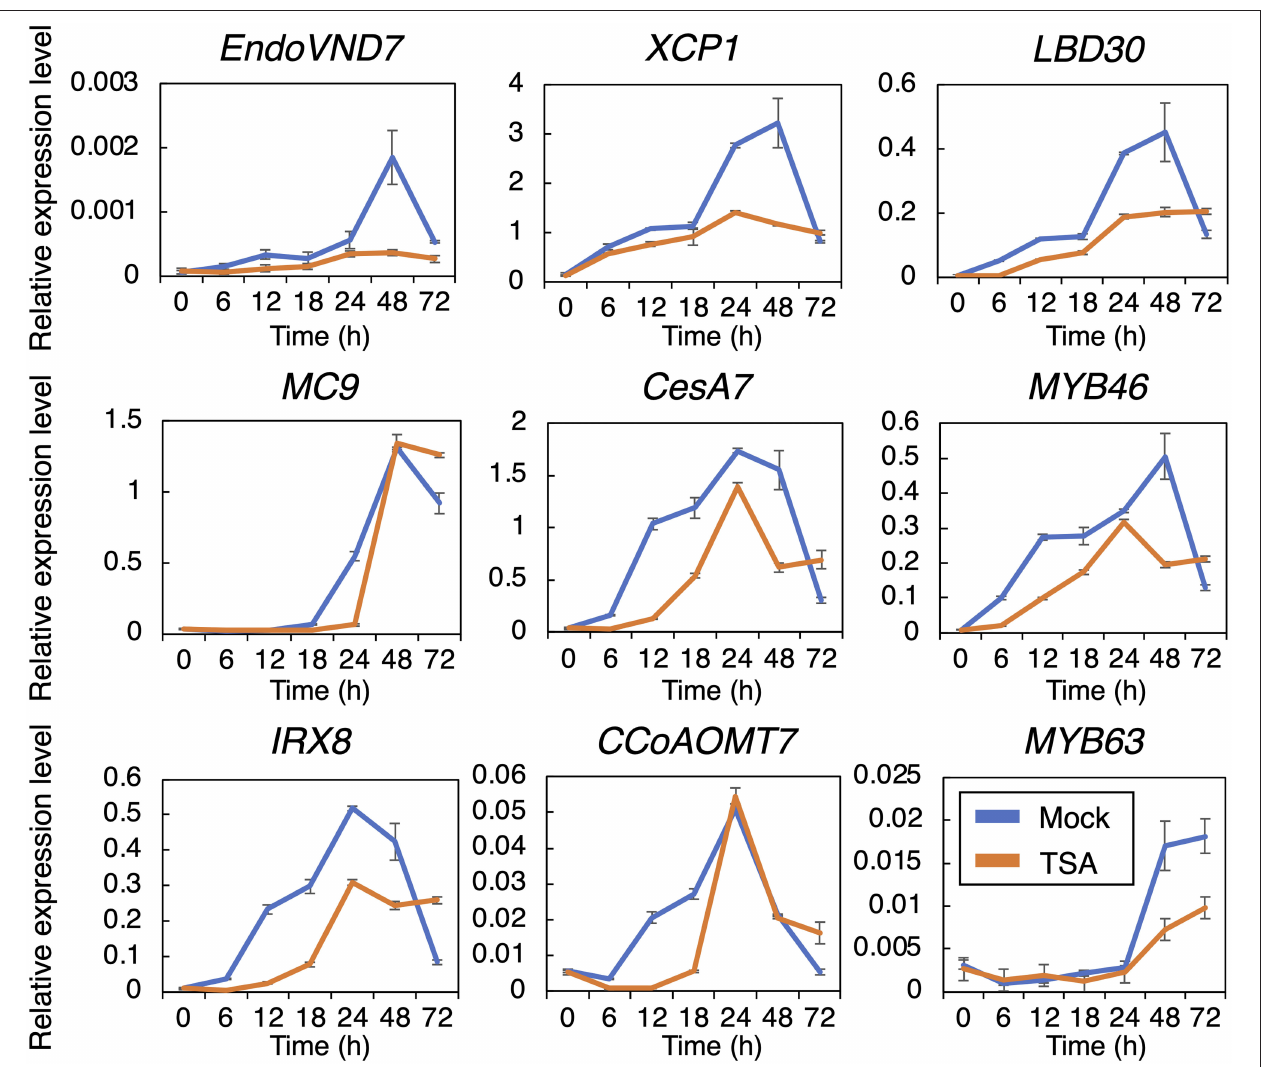
FIGURE 3 | Reverse transcription quantitative PCR analysis of the genes downstream of VND7 in VND7–VP16–GR seedlings treated with dexamethasone (DEX) and trichostatin A (TSA). Seven-day-old VND7–VP16–GR seedlings were treated with 10nM DEX and 5 µ M TSA and sampled after 0, 6, 12, 18, 24, 48, and 72h. The expression levels of the genes downstream of VND7 were normalized to the expression level of the internal control UBIQUITIN10 . Results are shown as means ± SD ( n =